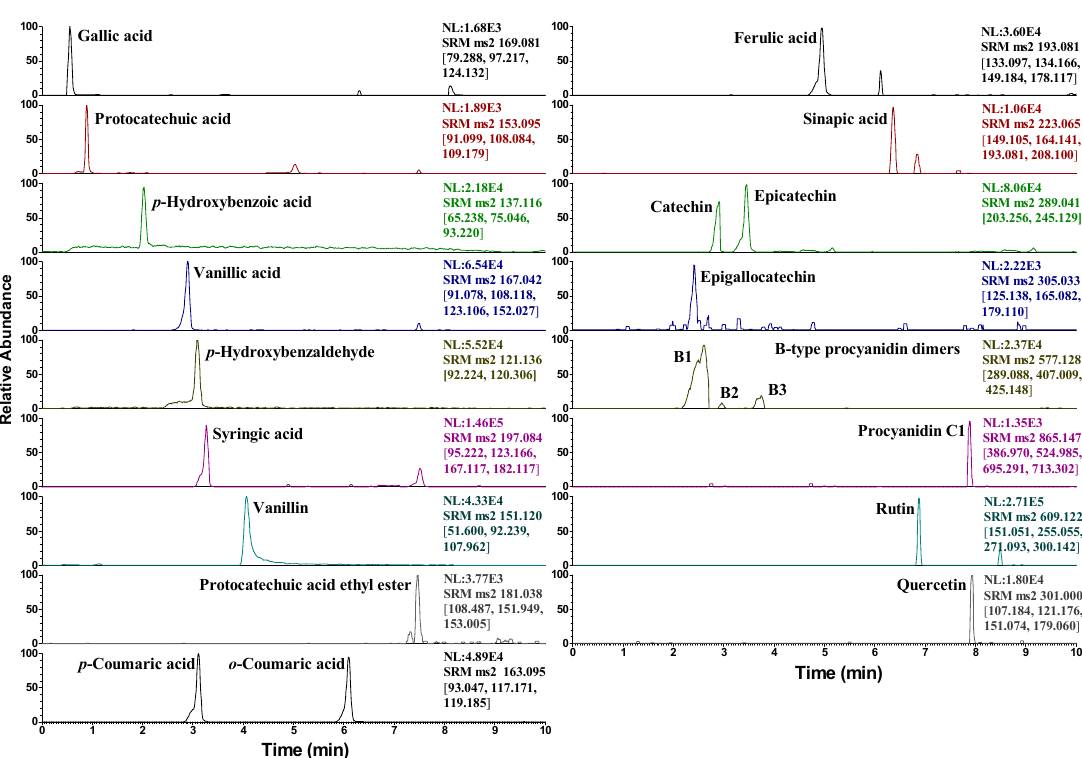
Figure 5. MRM chromatograms of Jingzhou wild rice containing 21 target compounds.